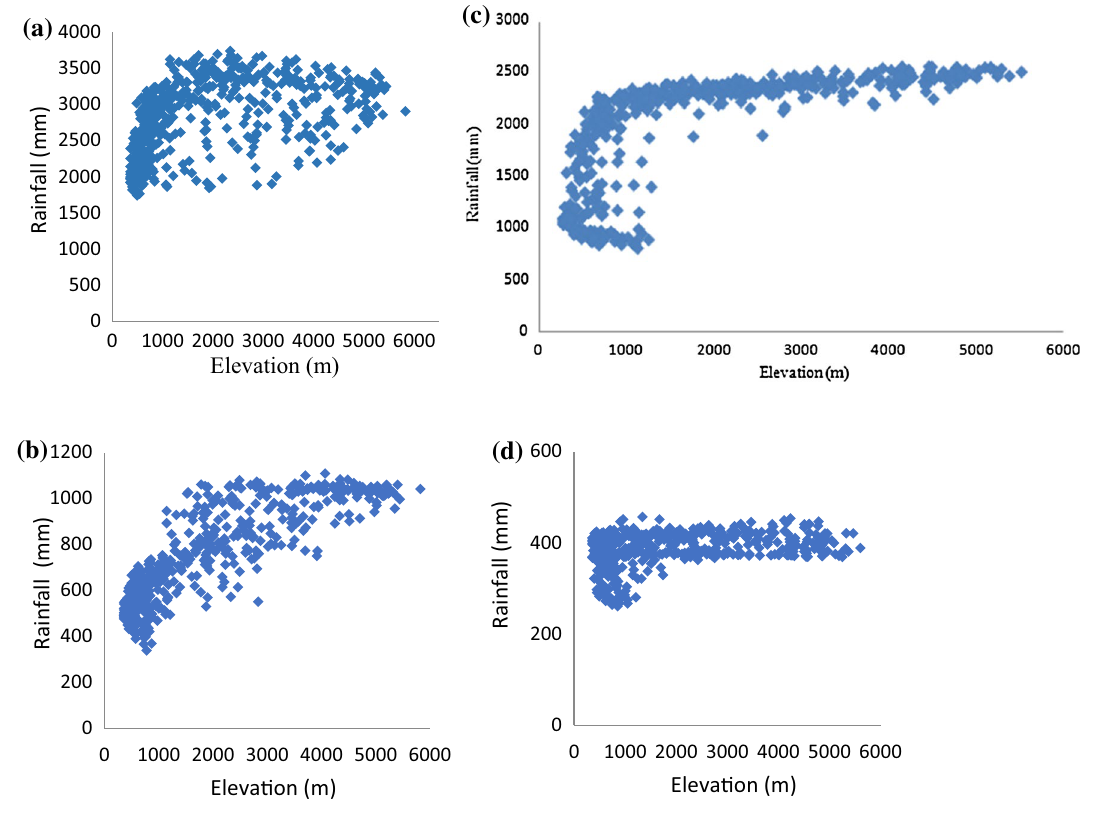
Fig. 8 Variation of rainfall with elevation for monsoon and winter period for ERA-Interim ( a , b ) and IMD ( c , d ) Fig. 9 Comparison of ERA- Interim rainfall data with observed rainfall data at a Pong dam and b Pandoh dam